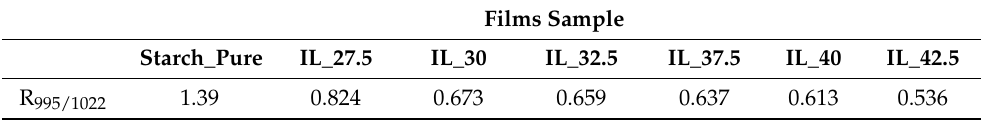
Table 2. ATR-FTIR band intensity ratio (R 995/1022 ) of the starch/PVA blends obtained. Films Sample